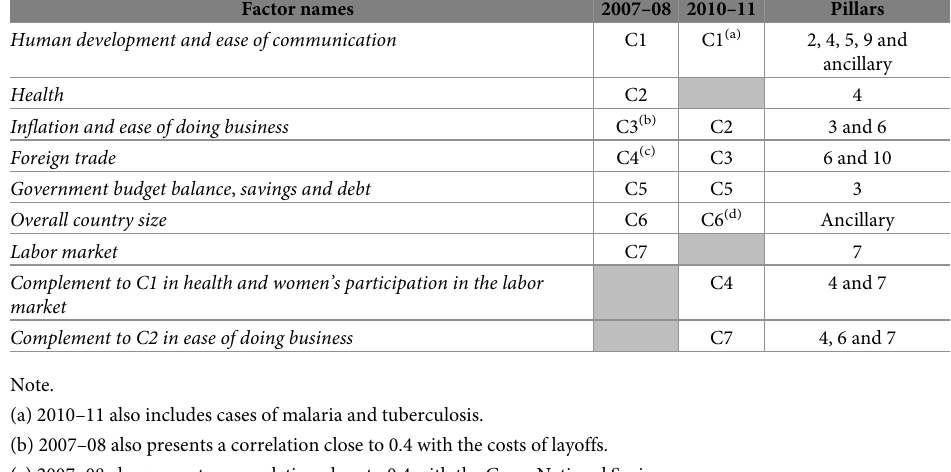
Table 6. Names of factors, components and